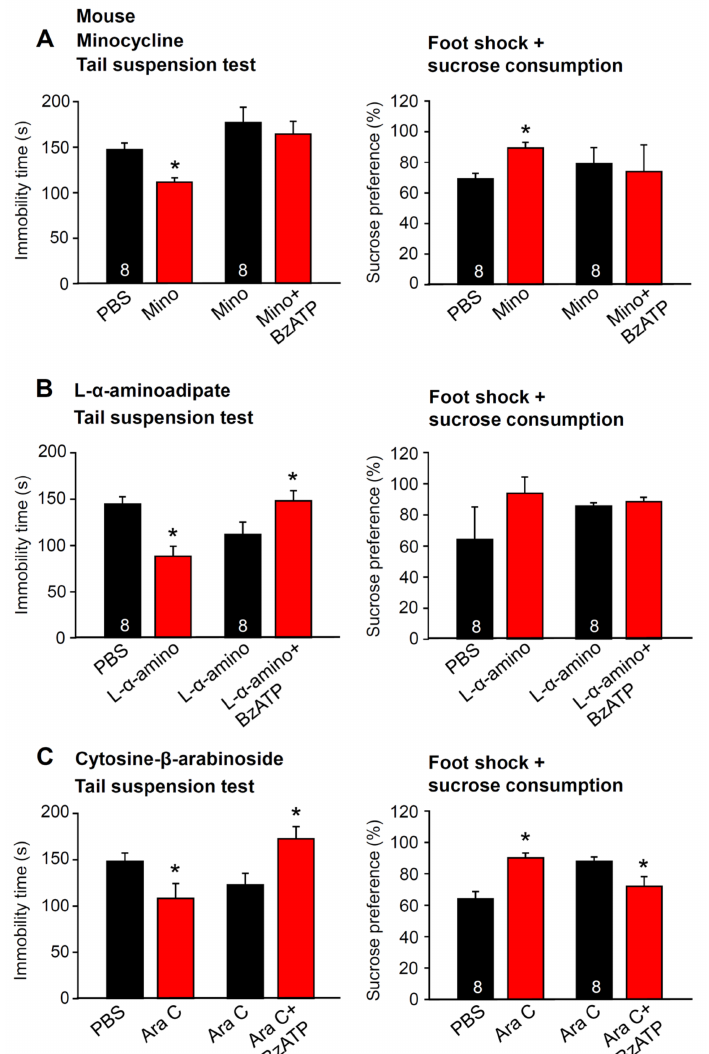
Figure 7. Effects of Bz-ATP in behavioral tests after the pretreatment of mice with drugs inhibiting microglial activation or interfering with astrocytic metabolism or oligodendrocytic proliferation. The immobility time in the tail suspension test and the sucrose preference after inescapable foot shock was measured in the left and right panels of A – C , respectively. Bz-ATP (10 µ M) was applied unilaterally to the lateral ventricle of the brain. ( A ) blockade of microglial activation by minocycline (see Section 4) abolishes the prolongation of the TST immobility time (left panel) and the foot shock- induced decrease in sucrose preference (right panel), normally observed in response to Bz-ATP. ( B ) selective damage to astrocytes by L- α -aminoadipate does not change the prolongation of the TST immobility time (left panel) but abolishes the foot shock-induced decrease in sucrose preference (right panel), normally observed in response to Bz-ATP. ( C ) preferential blockade of oligodendrocytic proliferation by cytosine- β -arabinoside (Ara C), has no effect either on the prolongation of the TST immobility time (left panel), or the foot shock-induced decrease in sucrose preference (right panel), normally observed in response to Bz-ATP. * p < 0.05; statistically significant difference from the preceding column ( A , left panel , Mino, t = 4.258, p < 0.001, BzATP, t = 1.065, p = 0.305; A , right panel , Mino, t = 3.913, p = 0.002, BzATP, t = 0.253, p = 0.804; B , left panel , α -Amino, t = 4.153, p < 0.001, BzATP, t = 2.109, p = 0.046; B , right panel , α -Amino, t = 1.265, p = 0.227, BzATP, t = 0.782, p = 0.447; C , left panel , Ara, t = 2.196, p = 0.045, BzATP, t = 2.707; p = 0.0170; C , right panel , Ara, t = 4.636, p < 0.001, BzATP, t = 2.366, p = 0.033); Student’s t -test. The number of experiments is indicated for each pair of